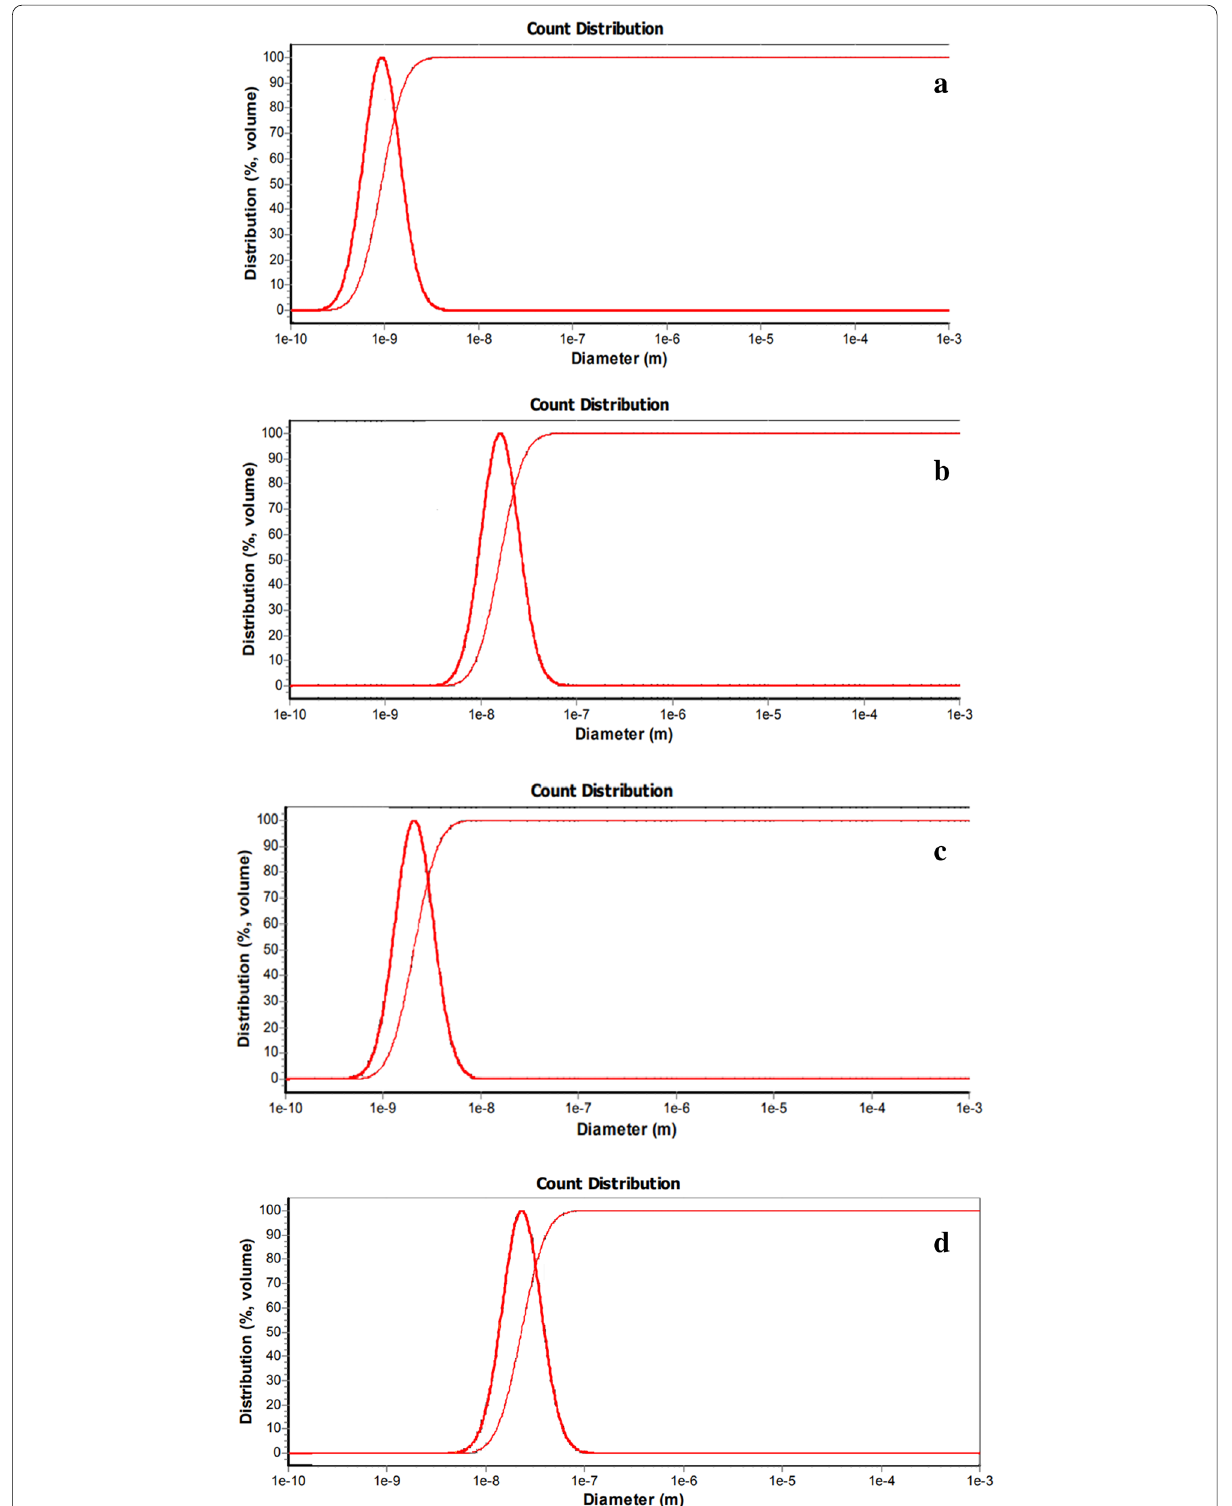
Fig. 1 DLS diagram of NN with different preparation methods. a 30 min homogenizer. b 15 min homogenizer. c 15 min ultrasonic probe. d 18 min ultrasonic